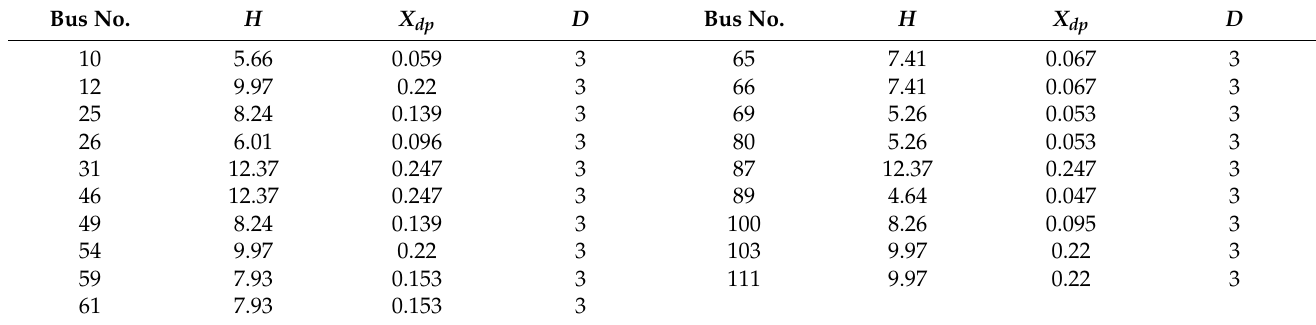
Figure 3. One-line diagram of the IEEE 118-bus system. Table 1. Machine dynamic parameters for the IEEE 118-bus system (machine base: 100 MVA).